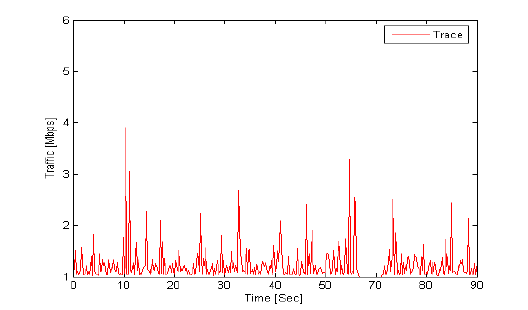
Fig. 1. Time Series of Traffic